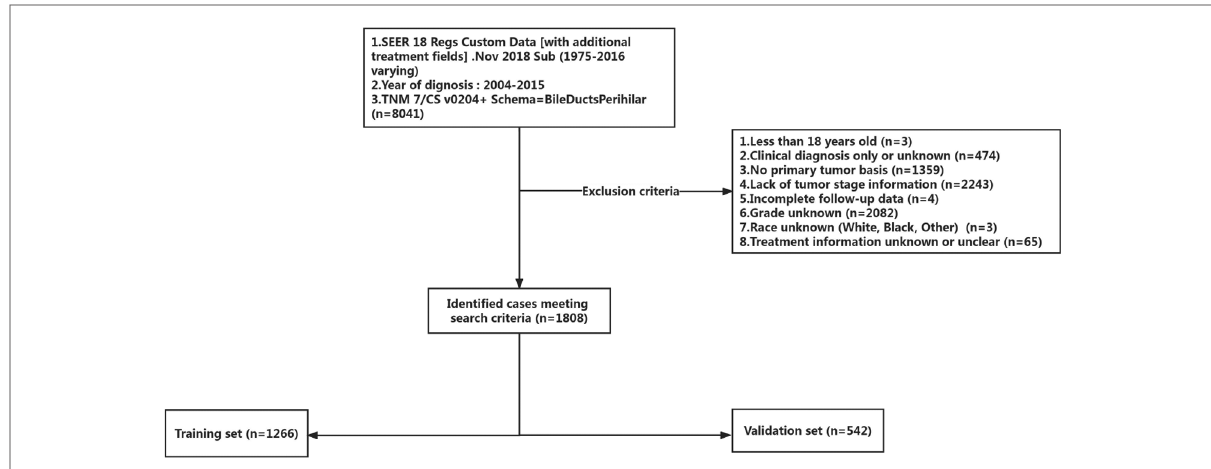
FIGURE 1 The inclusion and exclusion criteria fl owchart of recruited patients in the SEER database. A total of 1,808 patients were included, and these patients were randomly divided into a training set and a validation